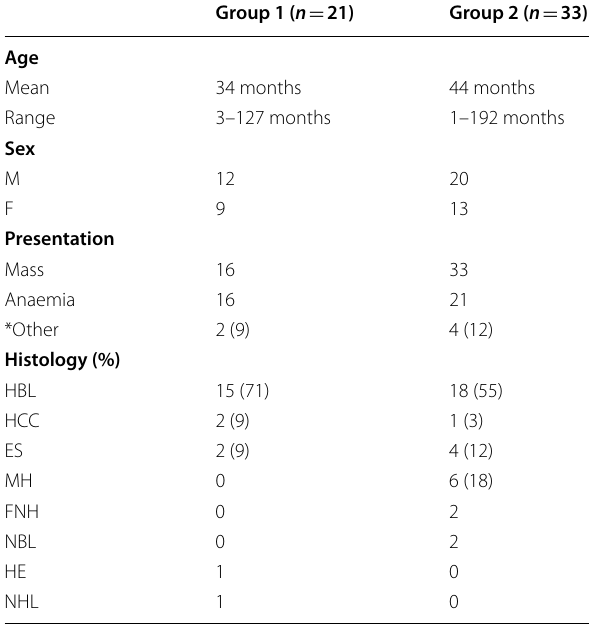
Table 1 Patient characteristics and histological subtypes (%)